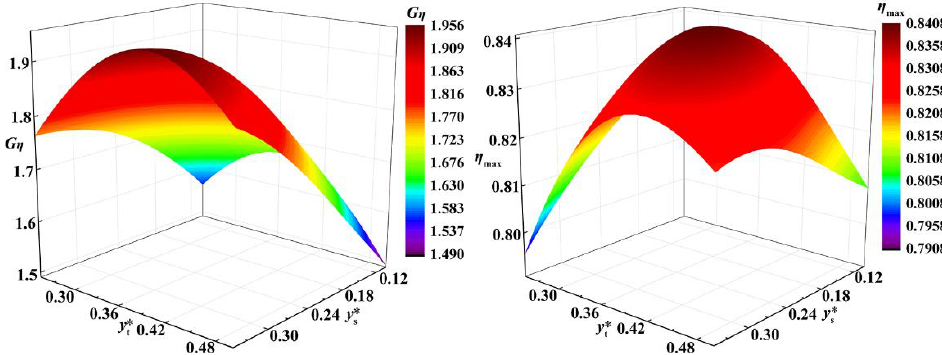
Figure 10. Nonlinear relationship between parameters and performances. Ten sample monitoring points are selected to evaluate the fitting accuracy of the response surface model (Figure 11). According to the predicted value of the response surface and the actual calculated values of the 10 sample monitoring points, the R 2 value can be calculated by Equation (22). The closer R 2 is to 1, the higher the fitting accuracy of the response surface model. It is concluded that the R 2 values of G η and η max are 0.99136 and 0.96857, respectively, which are both greater than 0.9, indicating that the response surface model is very reasonable.